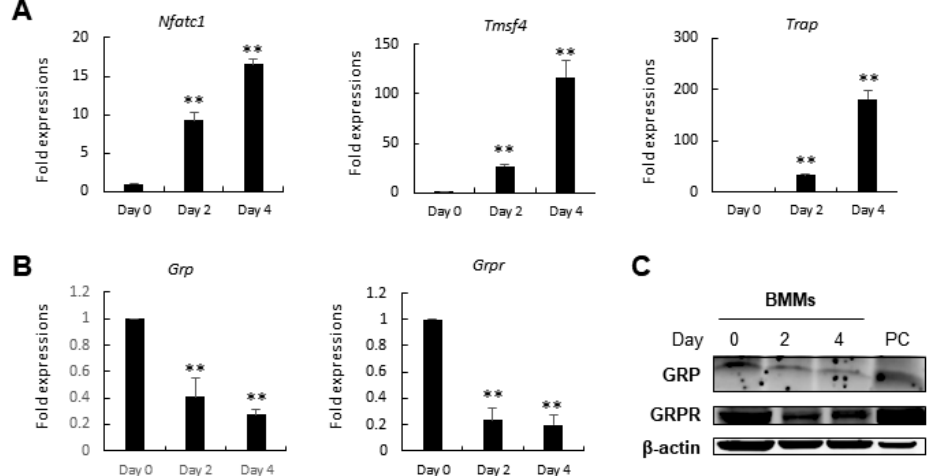
Figure 3. Grp and Grpr expressions are downregulated during osteoclastogenesis. ( A ) Expression of markers of osteoclastogenic differentiation increased in BMMs during osteoclastogenesis while ( B ) Grp and Grpr expressions decreased; ( C ) Protein analysis confirms the downregulation of GRP and GRPR during osteoclastogenesis. 3T3L1 cells at Day 7 were used as a positive control (PC). Quantitative data are presented as mean ± SD. ** p < 0.01 by ANOVA test. Asterisk shows a significant difference from Day 0 group.